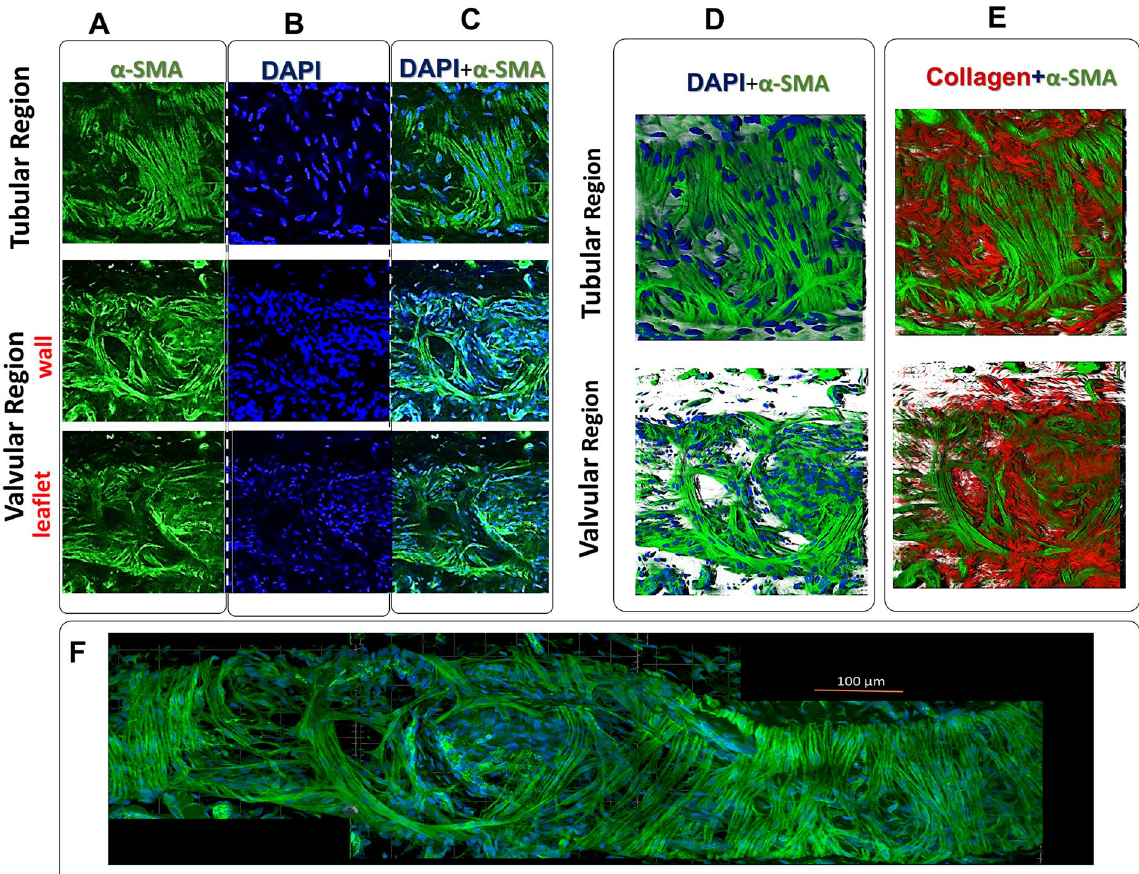
Figure 5. Lymphatic smooth muscle coverage and fiber organization in collecting lymphatic vessel from rat tails. A representative image (z-stack) staining for smooth muscle actin ( α -SMA; Panel A), nuclear staining (DAPI; Panel B), and merged SMA and DAPI (Panel C) for valvular and tubular regions of a lymphatic vessel from rat tails. The 3D reconstruction of actin fibers of LMCs with nuclear staining (DAPI and SMA; Panel D) and with collagen fibers were obtained from SHG imaging (collagen and SMA; Panel E). The vessel was fixed and placed on a glass slide for imaging. The images were taken from the same vessel and the imaging window dimensions and depth were ~300 µ m × 300 µ m and ~10 µ m respectively. The images from different locations were stitched together to obtain an image of the vessel (Panel